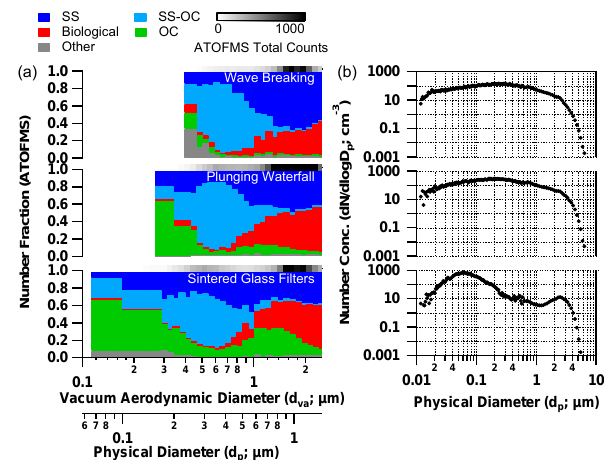
Figure 3. (a) Size-resolved chemical composition of SSA particles measured by ATOFMS for each bubble/aerosol generation method, noted in white text. The vertical scale indicates the number fraction of particles sampled by ATOFMS. The grayscale bar at the top of each panel indicates the number of particles sampled in each size bin. (b) Number size distributions measured by SMPS and APS, corresponding to the data shown in (a) . The sintered glass filter method generates a significantly different number size distribution of SSA particles and shows an enhancement in organic-rich parti- cles in the d va = 0.8–2µm range, when compared with the other two generation methods. The second size axis in (a) labeled “Physical Diameter” is provided for comparison with (b) , noting that d va is the size metric directly measured by